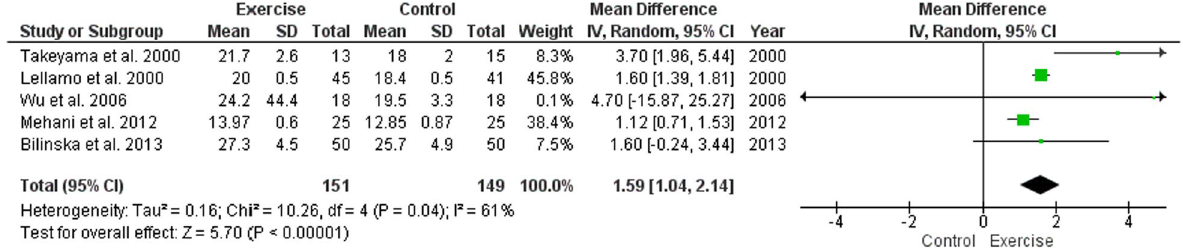
Fig. 1 Forest plot of comparison: exercise versus control, outcome: peak oxygen